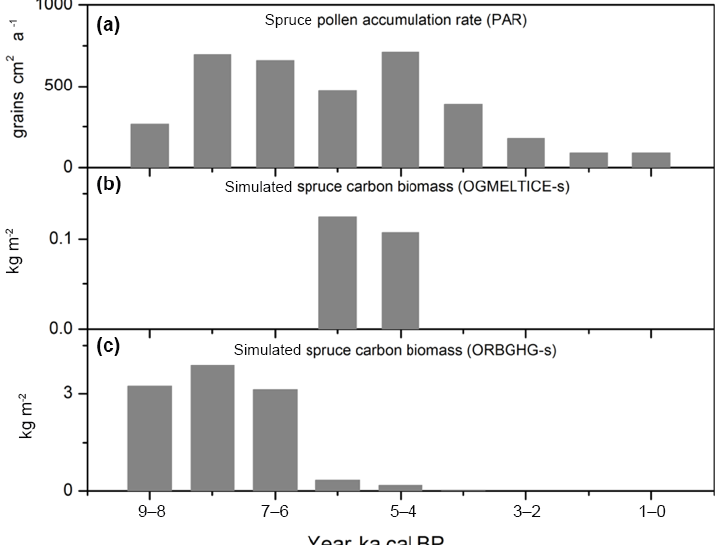
Figure 12. Time series comparisons between the pollen data from Kharinei Lake in the modern tundra (62.75 ◦ N, 67.37 ◦ E) and the simulated spruce biomass from the nearest grid cell (62.50 ◦ N, 67.00 ◦ E). (a) Pollen accumulation rate (PAR) data for spruce, (b) the simulated spruce biomass based on paleoclimate scenario OGMELTICE-s, and (c) the simulated spruce biomass based on paleoclimate scenario ORBGHG-s. The simulated biomass and PAR values are shown as mean values of 1000-year